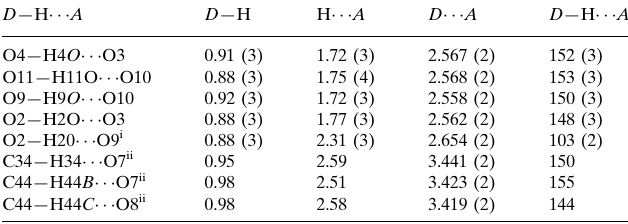
Hydrogen-bond geometry (A˚ , (cid:2)